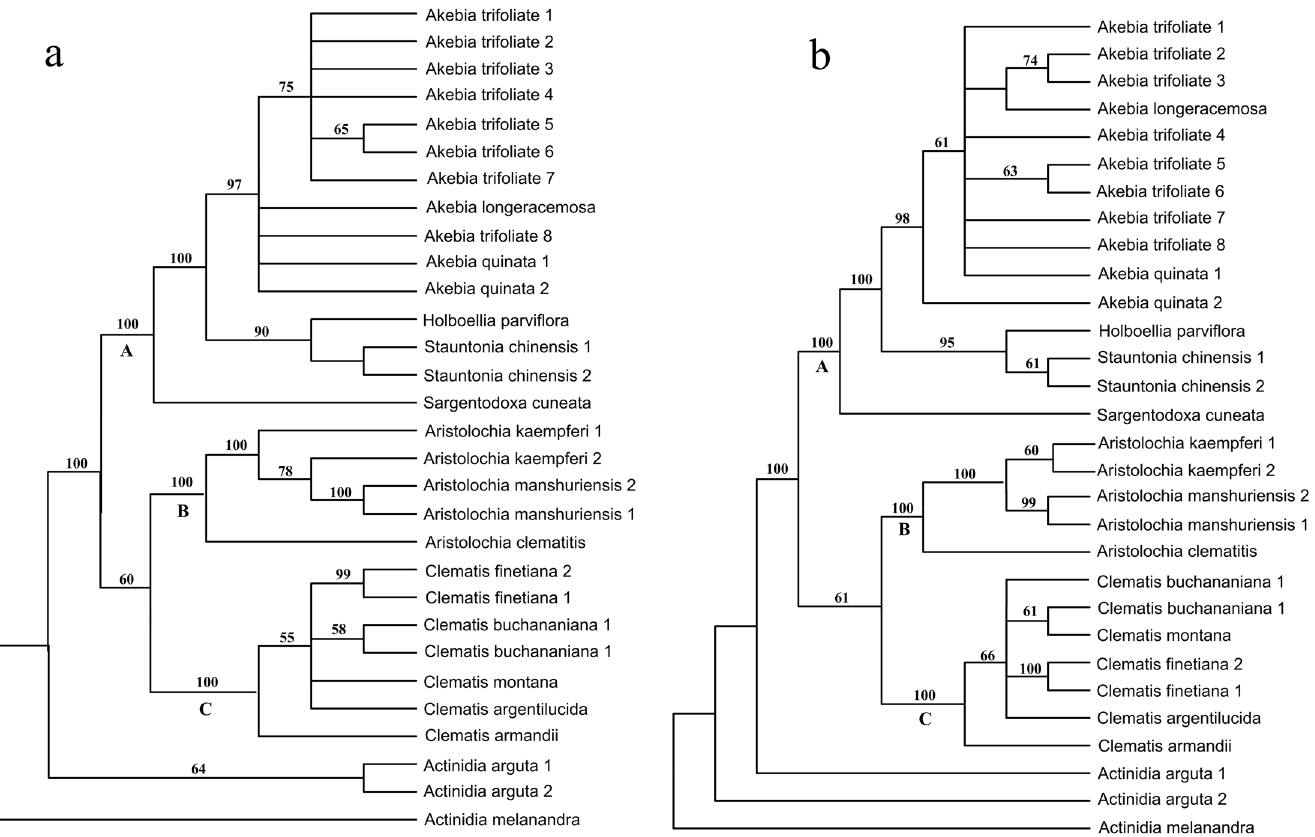
Fig 3. Comparison of MP trees inferred from sequences with different align methods. a. MP tree inferred from sequence alignment by Clustal X; b. MP tree inferred from sequence alignment by secondary structure information. Numbers on the branches indicate the bootstrap values of MP above 50%, numbers following a species name represent individual